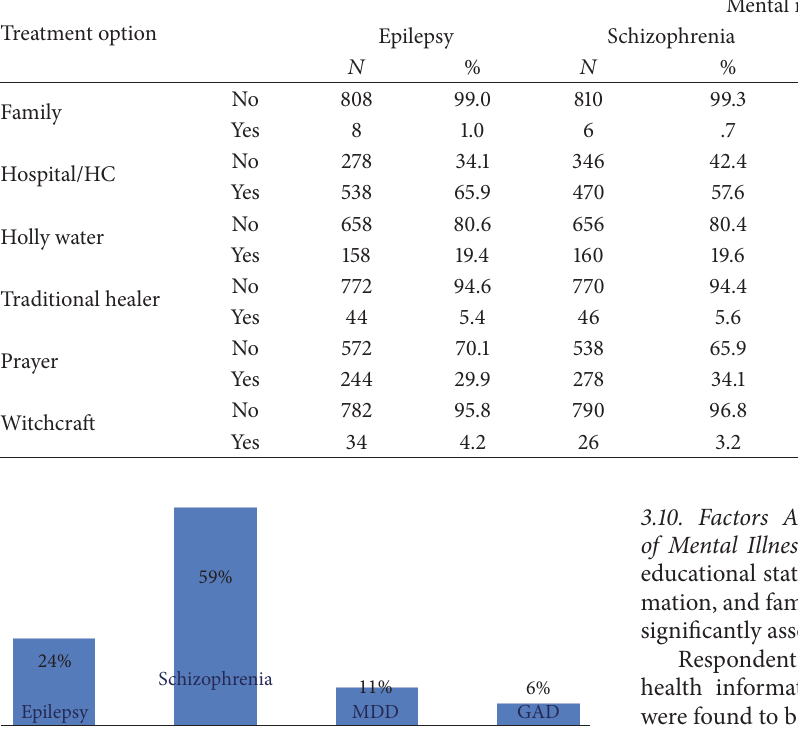
Figure 4: Distribution of respondents’ perceived severity of mental illness among residents of Gimbi town, West Wellega Zone, Oromia region, Ethiopia, 2014 ( 𝑛 = 816